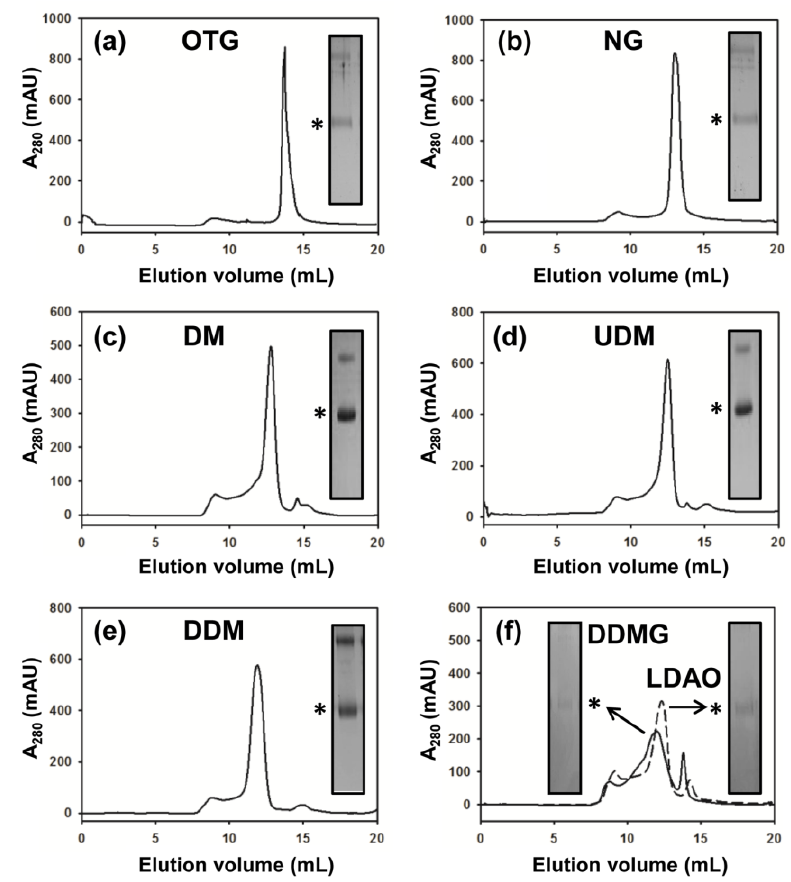
Figure 3. Detergent screening of MdtM. SEC chromatograms of MdtM in: ( a ) n -octyl-β- D - thioglucoside (OTG); ( b ) n -nonyl-β- D -glucoside (NG); ( c ) decylmaltoside (DM); ( d ) undecylmaltoside (UDM); ( e ) n -dodecyl β- D -maltoside (DDM); and ( f ) n -dodecyl- N , N - dimethylamine- N -oxide (LDAO) and n -dodecyl- N , N -dimethylglycine (DDMG). The